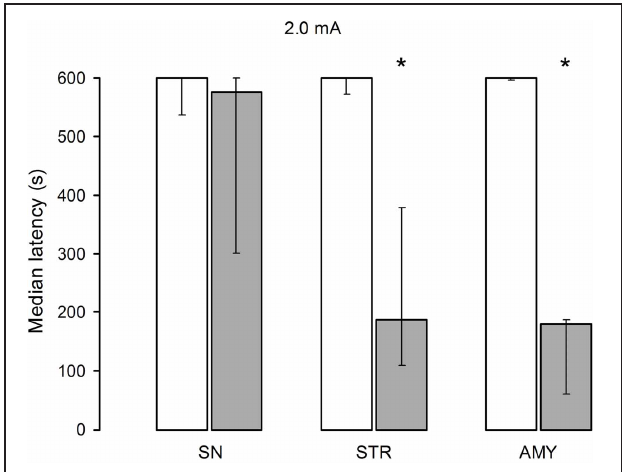
FIGURE 3 | Median retention scores (with interquartile range) of groups of rats trained in one-trial inhibitory avoidance and injected with either isotonic saline solution (open bars) or 2% lidocaine (filled bars). Training with 2.0mA protected memory in animals infused with lidocaine into the substantia nigra (SN), but not in those infused into the striatum (STR), or amygdala (AMY). ∗ p < 0 . 05 between saline and lidocaine.